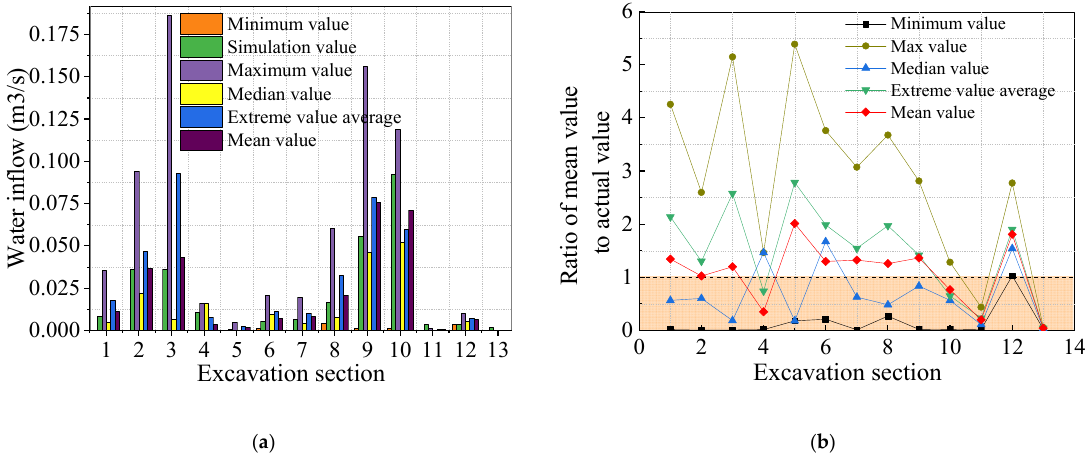
Figure 16. Comparison of the measured values of the water inflow without grouting excavation. ( a ) Comparison of theoretical and measured water inflow under different permeability coefficients, ( b ) Ratio of different theoretical water inflow to measured values. Where 1 stand for ZDDK365+260 to +250, 2 stand for ZDDK365+270 to +250, 3 stand for ZDDK365+280 to +250, 4 stand for PDK365+317.5 to +312.5 circular segments, 5 stand for PDK365+322.5 to +312.5 circular segments, 6 stand for PDK365+327.5 to +312.5 circular segments, 7 stand for ZDDK365+302.5 to +292.5 circular segments, 8 stand for ZDDK365+311.5 to +292.5 circular segments, 9 stand for ZDDK365+315.5 to +292.5 circular segments, 10 stand for ZDDK365+321.5 to +292.5 circular segments, 11 stand for ZDDK365+284 to +275, 12 stand for ZDDK365+293 to +275, and 13 stand for ZDDK365+302.5 to